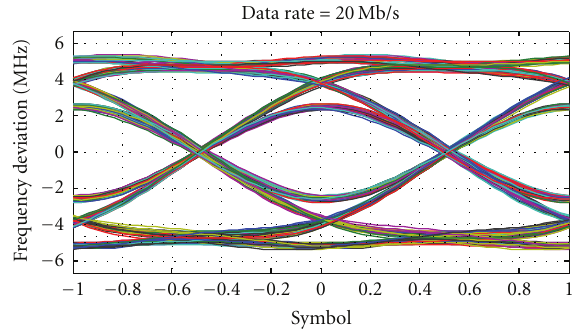
Figure 4: Block diagram of phase quantization noise cancellation technique [20].